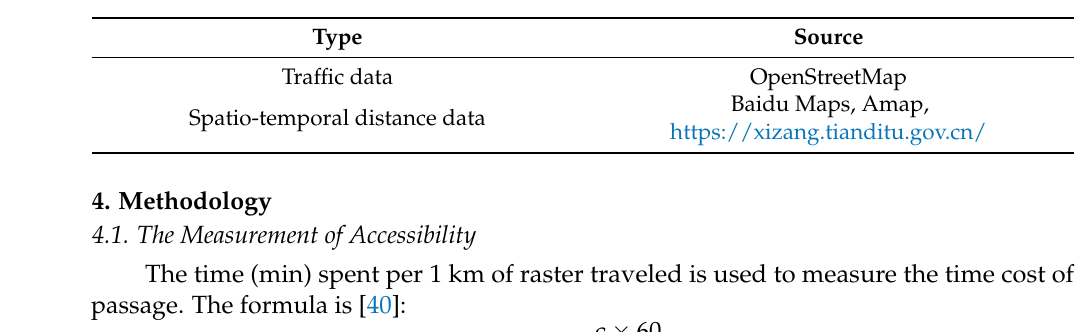
Table 5. Traffic data types and